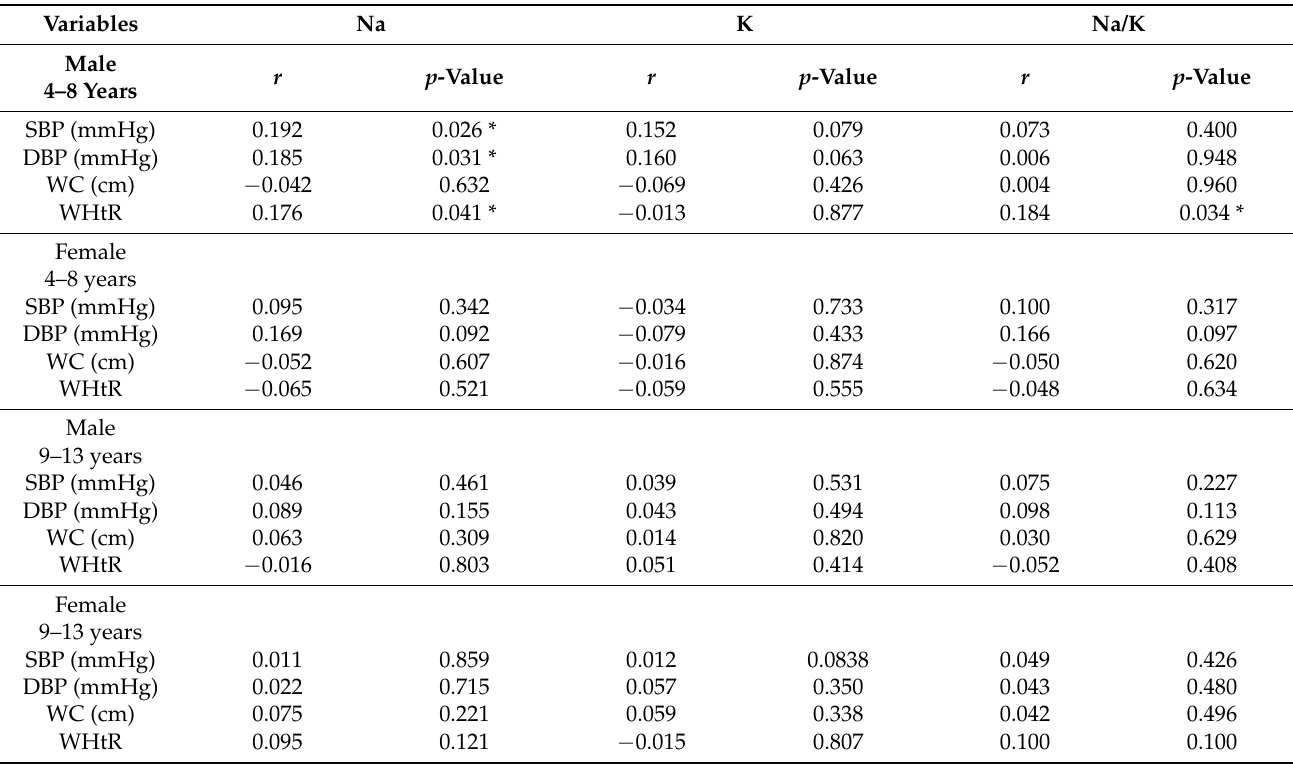
Table 4. The correlation of sodium, potassium intake and with SBP, DBP, WC, and WHtR in Pearson